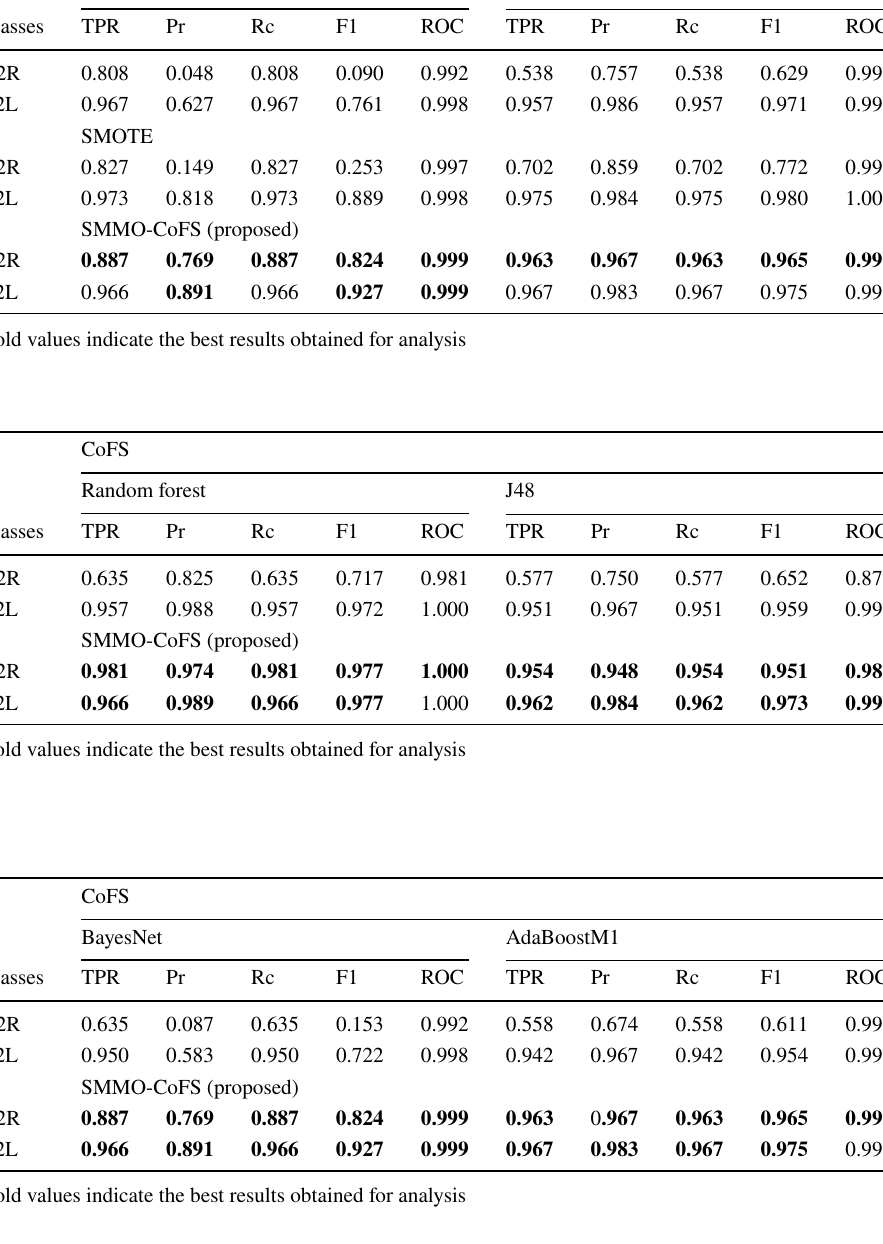
Table 4 Performance evaluation of SMMO-CoFS method in terms of TPR, Pr, recall, F 1 and ROC for U2R and R2L classes using BayesNet and AdaBoostM1 classifiers by comparing with original data set